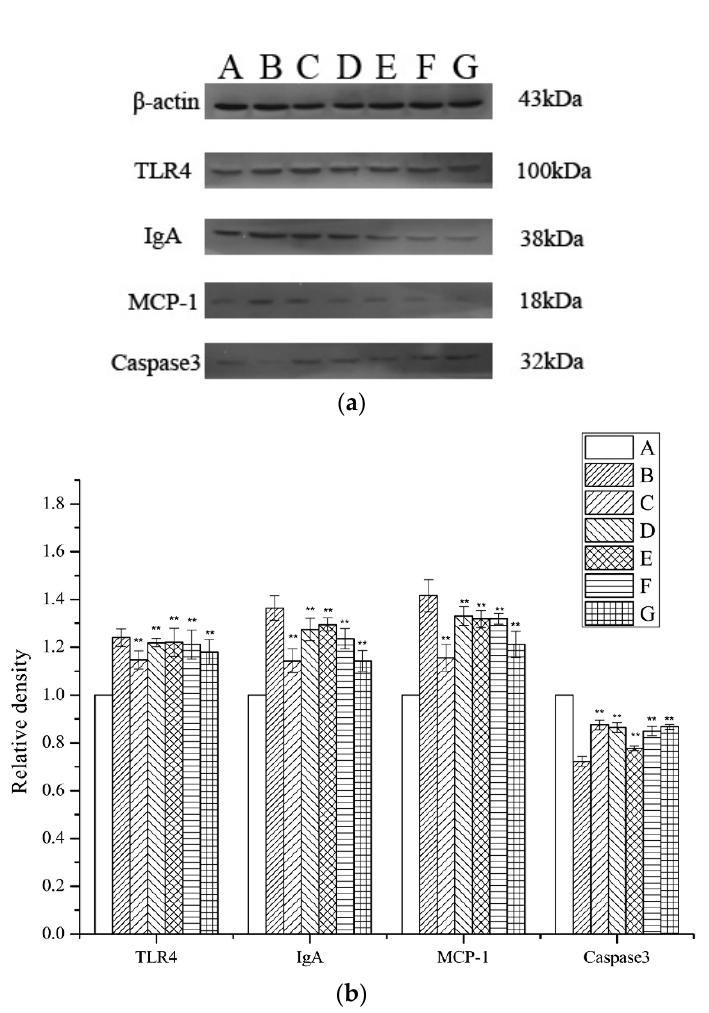
Figure 8. TLR4, MCP-1, IgA, and caspase-3 expression in rat kidney tissues. ( a ) TLR4, IgA, MCP-1, and caspase-3 expression levels were analyzed by Western blotting. ( b ) Quantitative analysis of TLR4, IgA, MCP-1, and caspase-3 protein levels. A: Healthy, normal controls; B: IgAN model group; C: prednisone acetate group; D: tripterygium glycoside tablet group; E–G: treatment group that received 0.5, 1, and 2 g/kg periostracum cicadae. Data represent the mean ± standard deviation (** p < 0.01 vs model group).